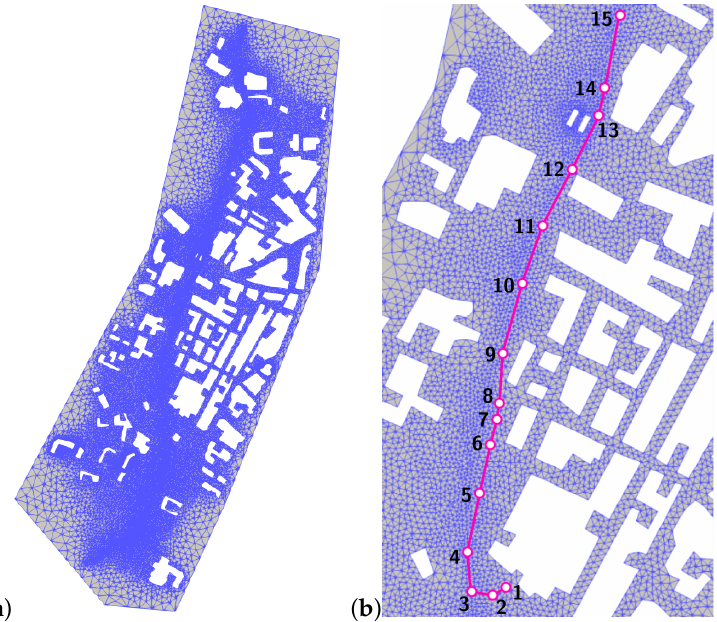
Figure 11. Flexible mesh used for the 2D model ( a ) and sewer network scheme together with link locations ( b ).